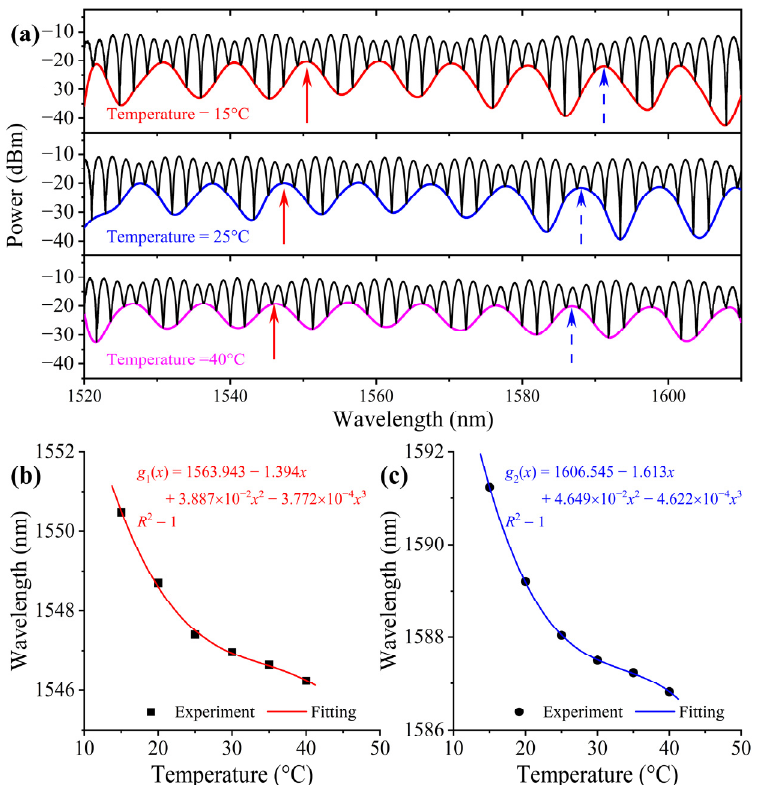
Figure 6. ( a ) Reflection spectra at different temperature and the two peaks at the initial position of 1550.5nm and 1591.2nm at 20%RH pointed by red and blue arrows. ( b , c ) wavelength as function of temperature of the two peaks